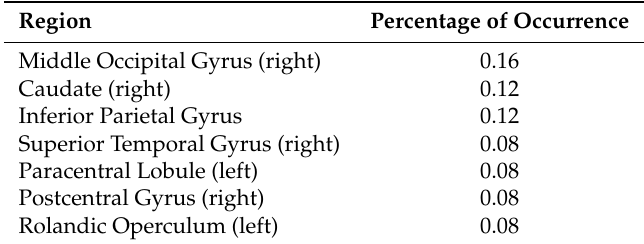
Figure 3. Glass brain visualization of the mean communicability difference between HC and AD for the region pairs with highest importance. The edge color and the edge thickness are descriptive of values. Table 2. Most occurring regions.